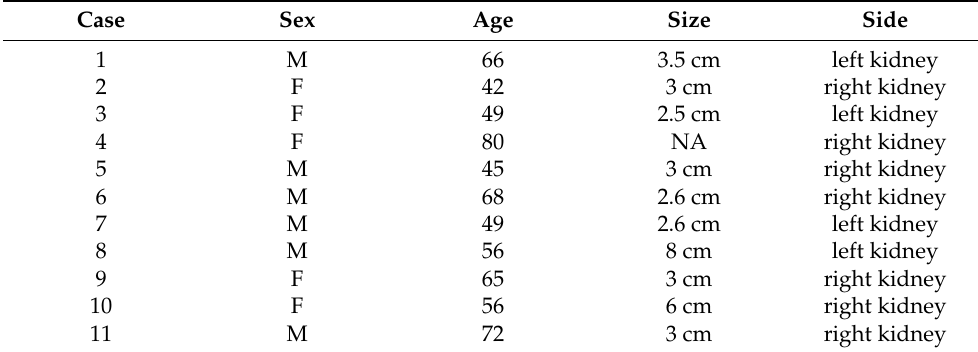
Table 1. Clinical and pathological characteristics of the 11